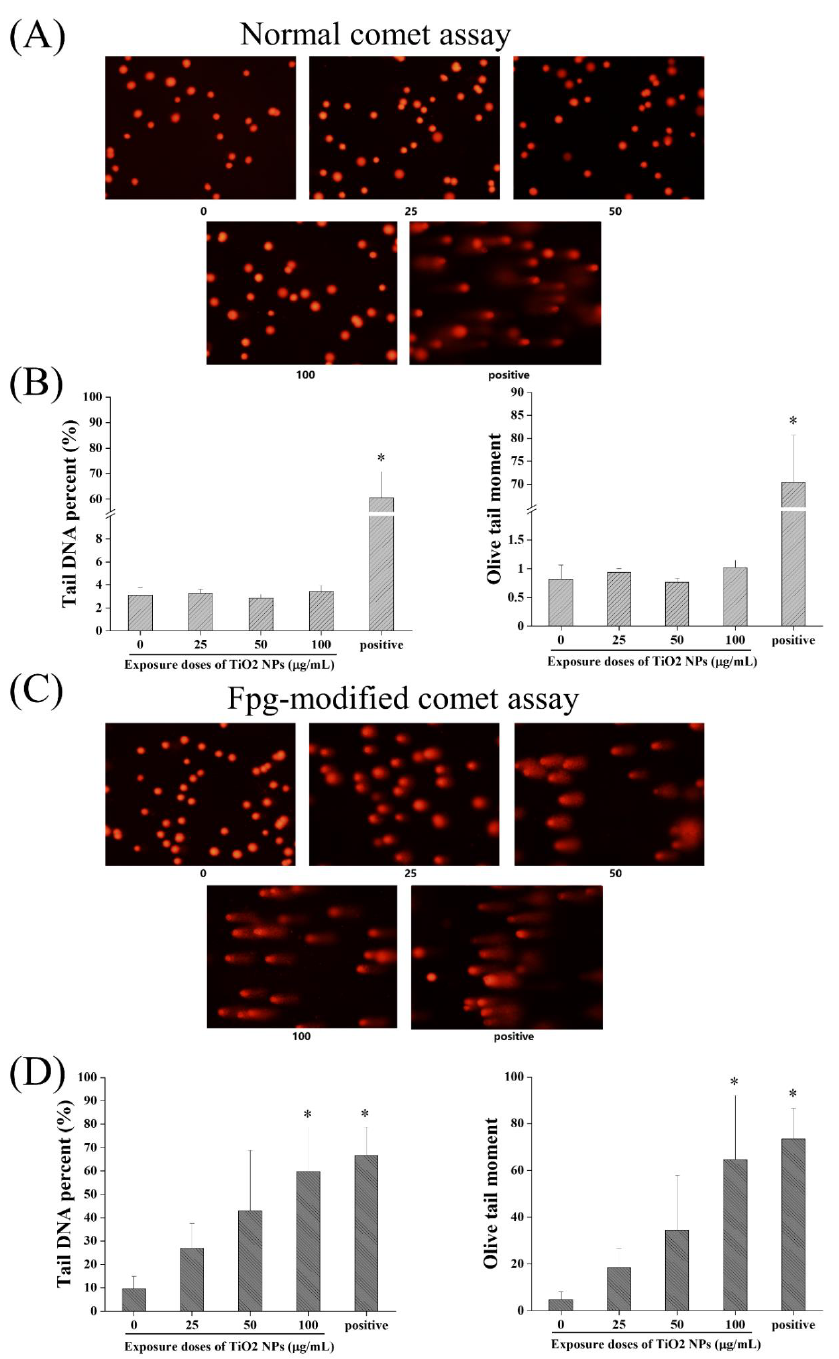
Figure 4. Effects of TiO 2 NPs on DNA damage in BEAS-2B cells using the comet assay. BEAS-2B cells were exposed to TiO 2 NPs at doses of 25, 50 and 100 µg/mL for 48 h or the positive control of hydrogen peroxide (H 2 O 2 ) at 1.53 mM for 5 min. ( A ) In the normal comet assay, no obvious comet cells were found, except for the positive control group. ( B ) Quantitative analysis showed no significant difference between different groups. ( C ) In the Fpg-modified comet assay, comet cells were found in the TiO 2 NP exposure groups. ( D ) Quantitative analysis of the Fpg-modified comet assay showed that both the Olive tail moment and comet tail DNA percentage in the 100 µ g/mL TiO 2 NP group were significantly higher than those in the control group. Significant difference from the control (* p <